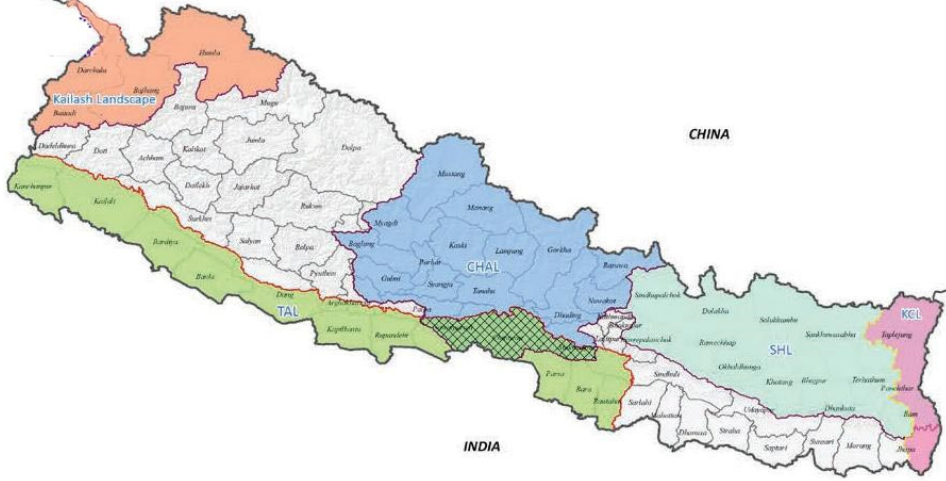
Figure 8. Zones of conservation landscapes in Nepal [Source: [24]].